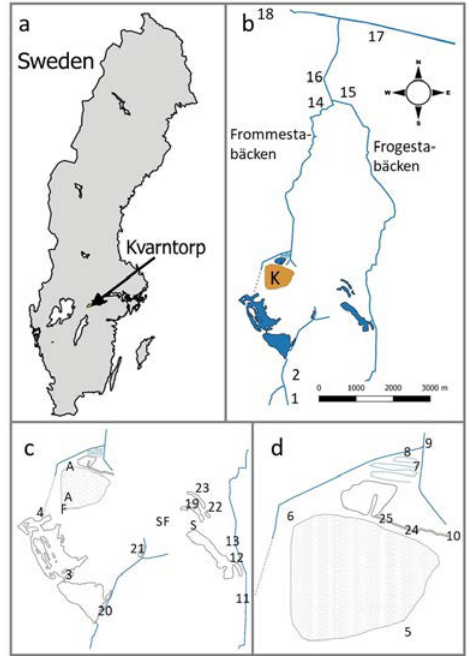
Figure 1. ( a ) Location of Kvarntorp; ( b ) map of the Kvarntorp area. K = waste deposit Kvarntorpshögen, W1, W2, W14, E15, 16 (W + E), 17, 18 = surface water sampling localities (W stands for west and E for east but only the numbers are shown on the map); ( c ) surface water sampling localities of which some are related to pit lakes, W3 = outlet lake Söderhavet, W4 = outlet lake Nordsjön, E12 = outlet lake Norrtorpssjön, 19 = lake Surpölen, 20 = eastern inlet lake Söderhavet, 21 = lake Mellansjön, 22 = lake Alaborg (south), 23 = lake Alaborg (north). Localities where solid samples were collected are marked with S (shale), F (fines) and A (Shale ash); ( d ) sampling localities in the waste deposit area, 5 and 6 = stagnant water, W7 = outlet Serpentine pond system, W8 = western stream, W9 = Frommestabäcken where it leaves the Kvarntorp area, 10 = water from the industrial area, 24 = ditch, 25 =